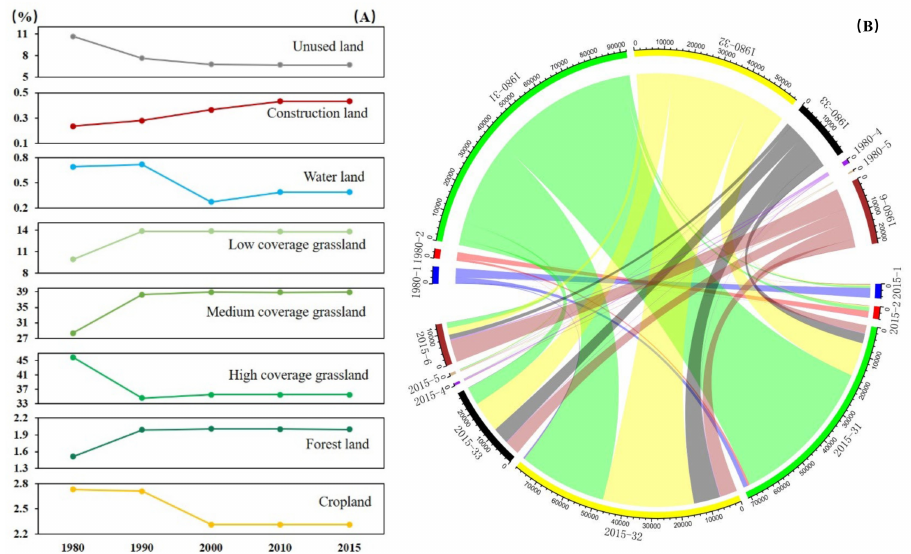
Figure 6. Changes in the area of individual categories( A ), and network structure LULC transfer matrix for the study area between 2010–2015 ( B